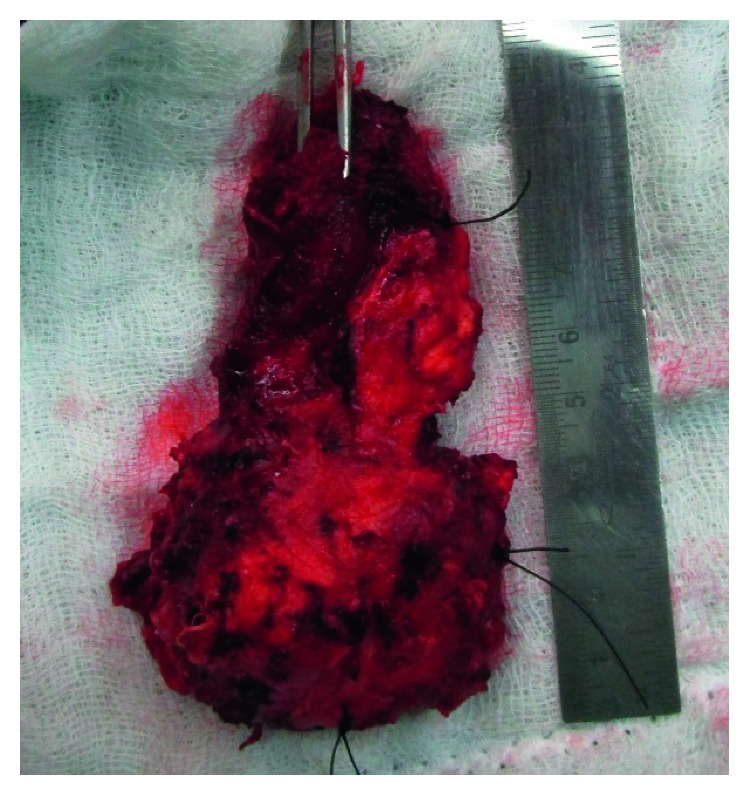
Excised specimen.